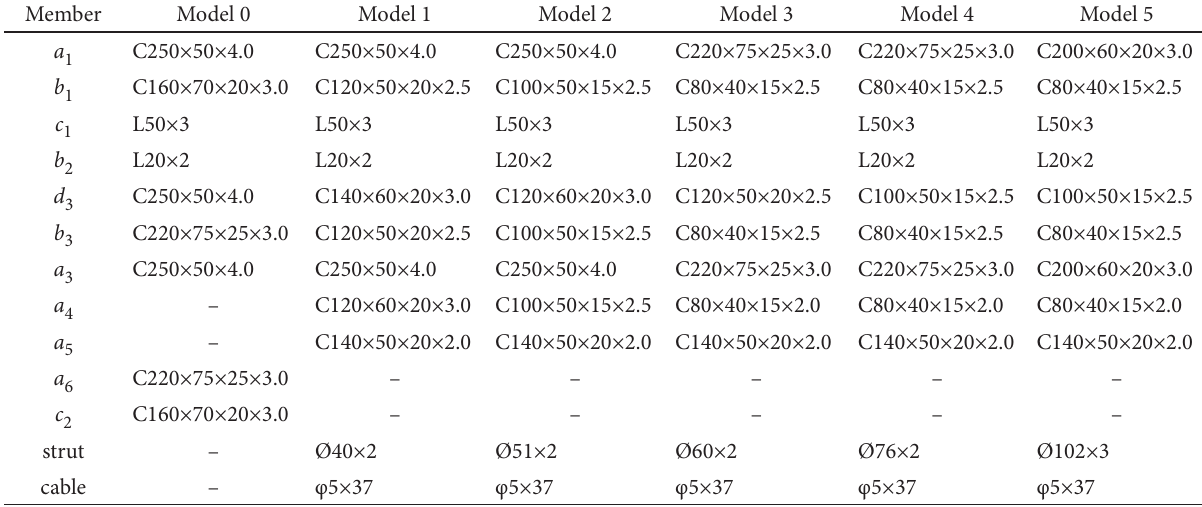
Table 2. Section dimensions of different